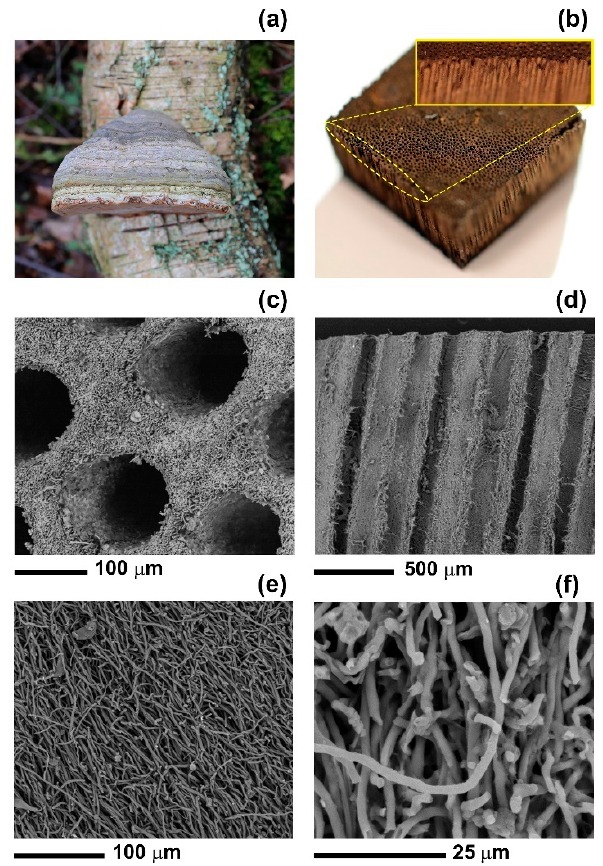
Figure 1. ( a ) Photograph of a Ganoderma growing on a fallen birch in South Yorkshire (UK). ( b ) Photograph of a sample of the spore-bearing fruiting body of a G. applanatum mushroom. Inset: high magnification photograph of the fungus microtubes. SEM images of ( c ) the bottom surface and ( d ) the